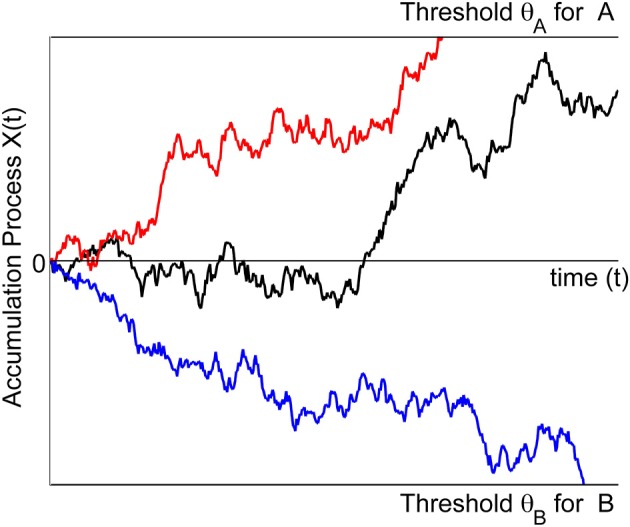
The trajectories symbolize the accumulation process for three different trials. In one trial (red) the process is absorbed at the boundary for making an A response. In another trial (blue) the process is absorbed at the boundary for making a B response. For the third trial (black) the accumulation process still evolves and no response is yet initiated.